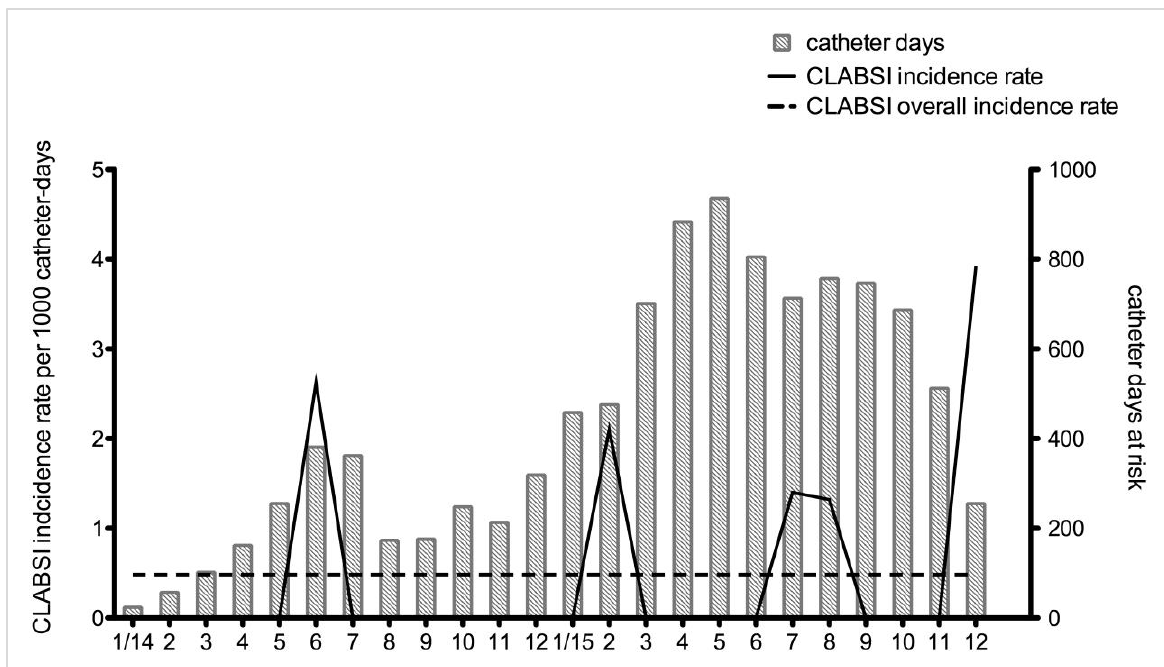
Figure 1: Incidence rate of central line-associated bloodstream infections (CLABSIs) per catheter-days per